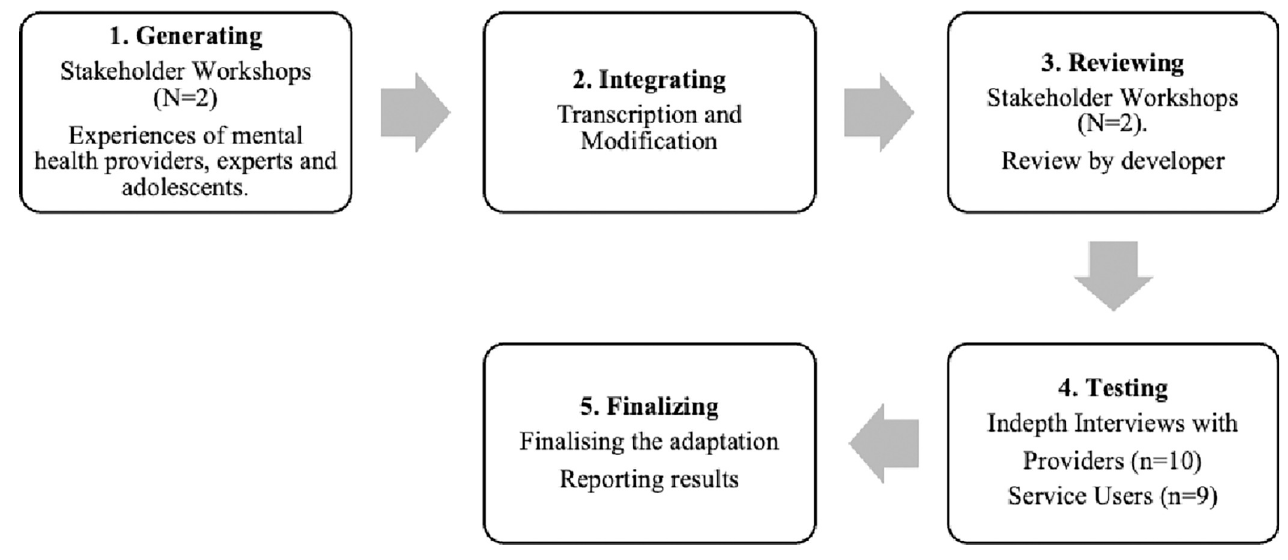
Fig 1. Intervention adaptation